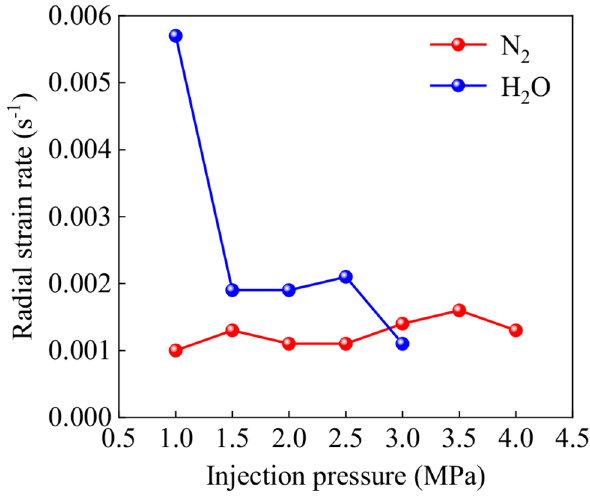
Fig. 5 Radial strain rate versus injection pressure in the early phase (within 4 h) of each injection pressure